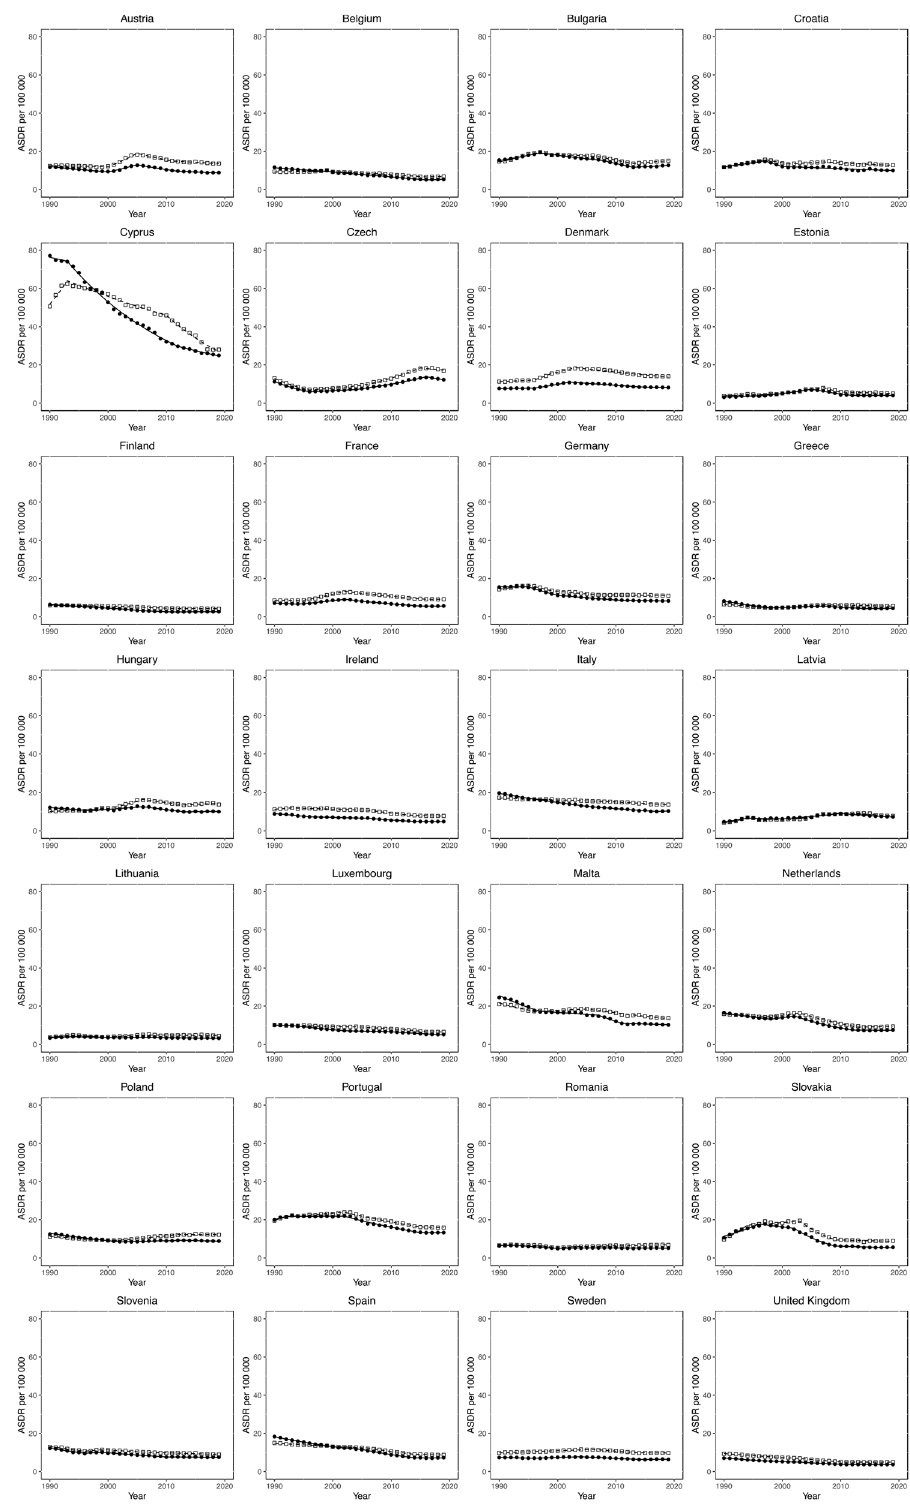
Figure 2. Trends in T2DM mortality. Trends in age-standardised death rates (ASDRs) per 100,000 population resulting directly from type 2 diabetes mellitus (T2DM) in all European Union (EU) countries and the UK from 1990 to 2019. Open squares represent males, filled circles represent